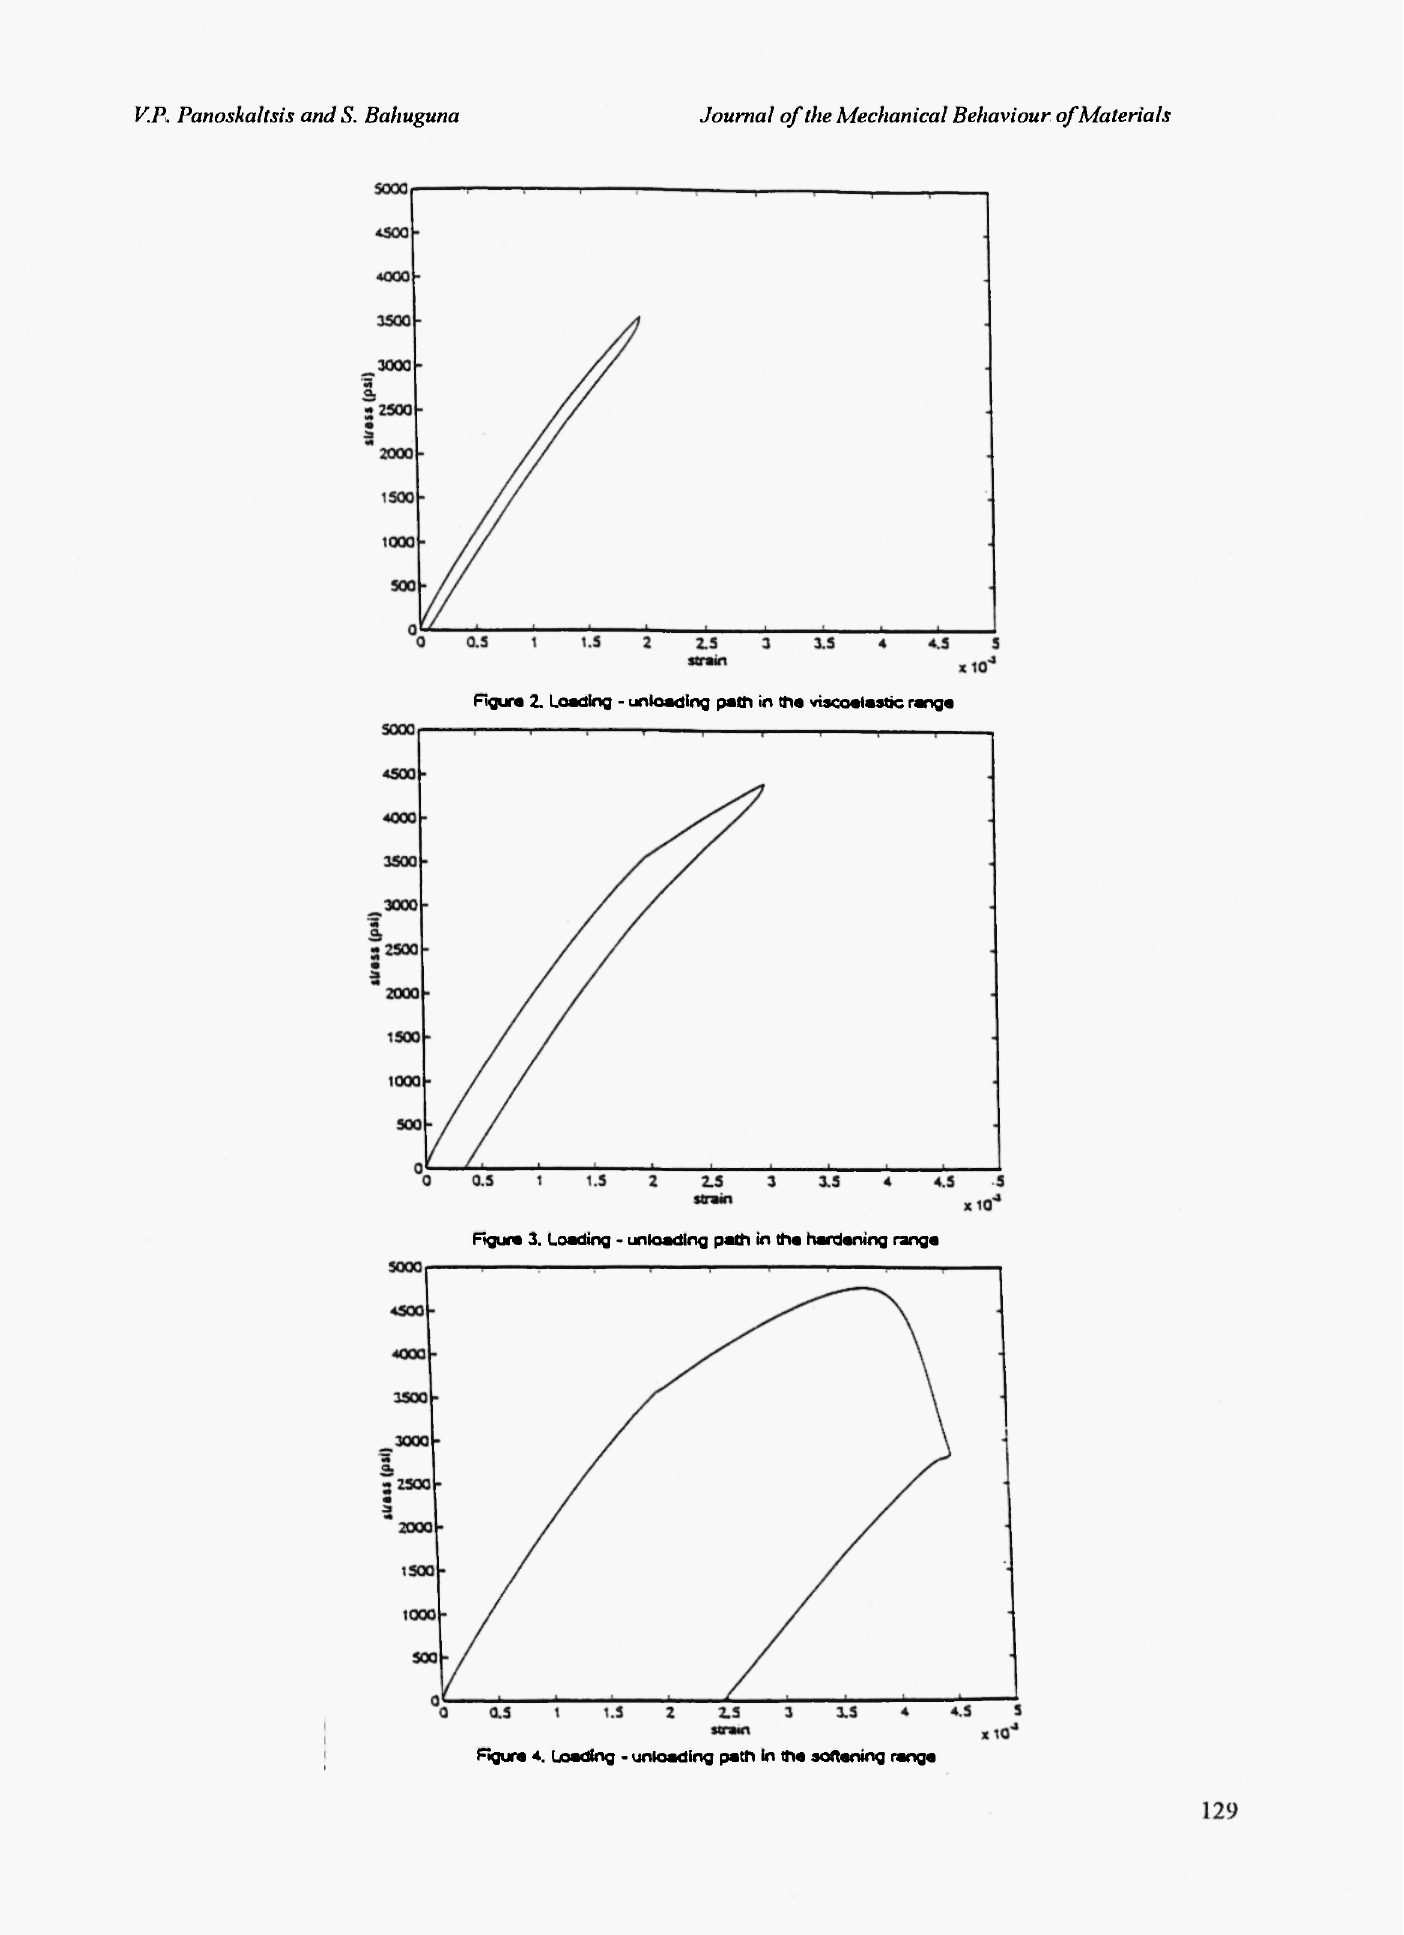
Figure 4. Loading - unloading path in the softening